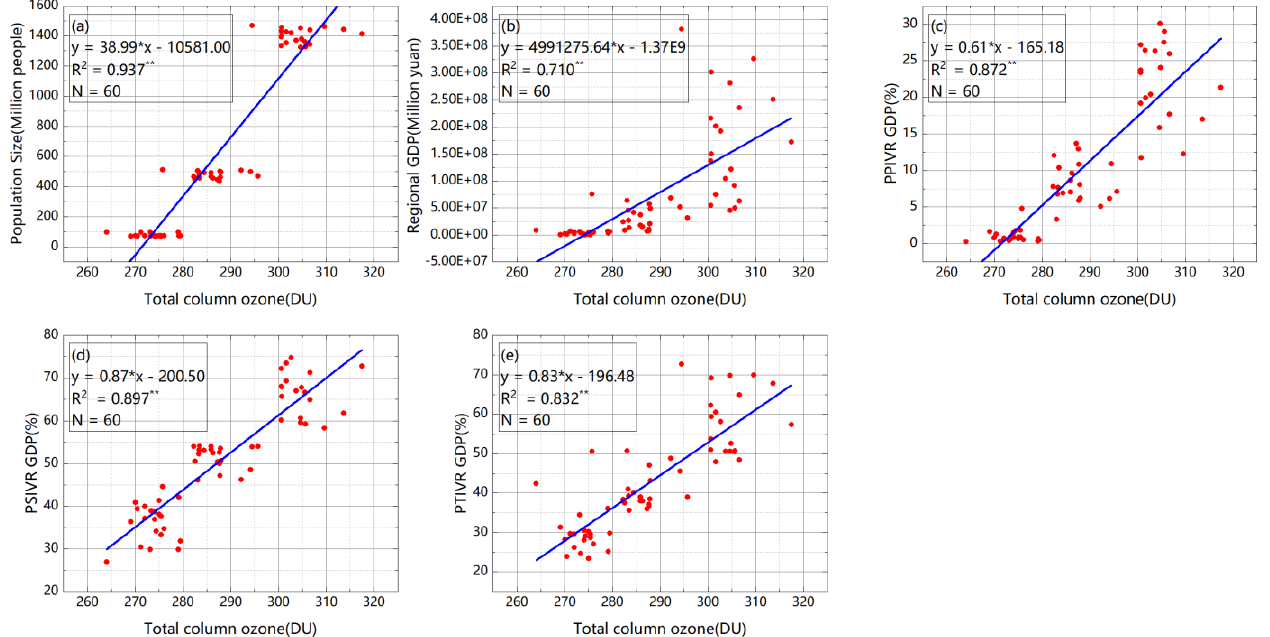
Figure A6. Scatterplot of the TCO and socioeconomic factors. Where PPIVR, PSIVR, and PTIVR distribution are Proportion of Primary Industry Value over Regional GDP, Proportion of Secondary Industry Value over Regional GDP, and Proportion of Tertiary Industry Value over Regional GDP.